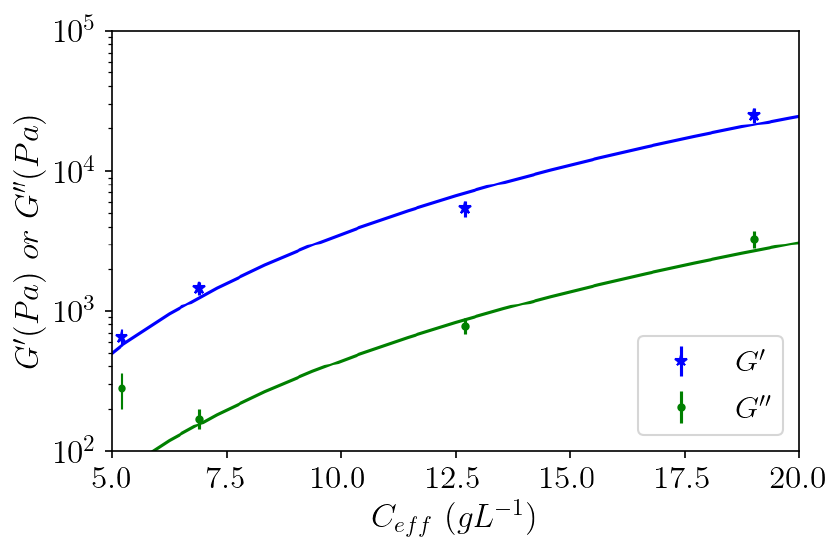
Figure 12. Elastic and viscous moduli for APP-E as a function of the effective concentration obtained at low angular frequencies. (Values correspond to the dashed lines in Figure 11). Continuous lines correspond to a power law fit~C eff2.8 .